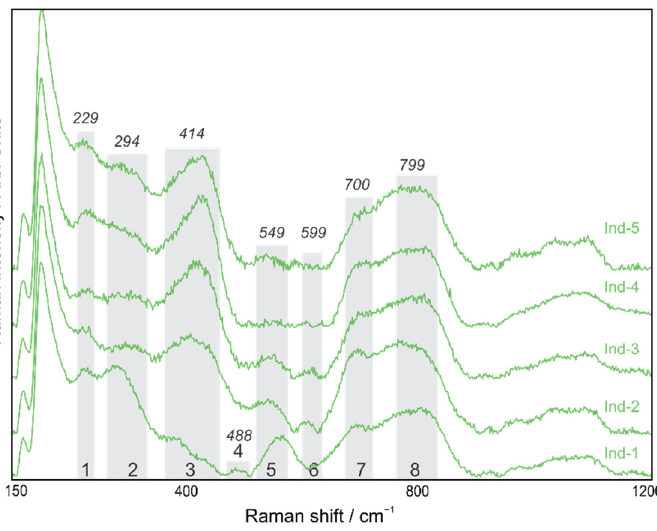
Figure 3. Raman spectra of Indonesian pseudorutile showing assigned pseudorutile bands (Table 2). Table 2. Assignment of Raman peaks for pseudorutile and kleberite (average values in cm − 1 ). Band